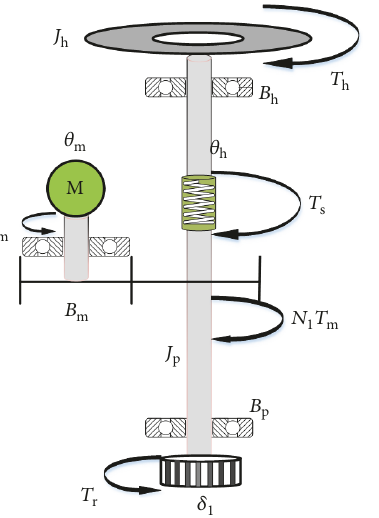
Figure 2: Schematic diagram of a simplified dynamic EPS system.